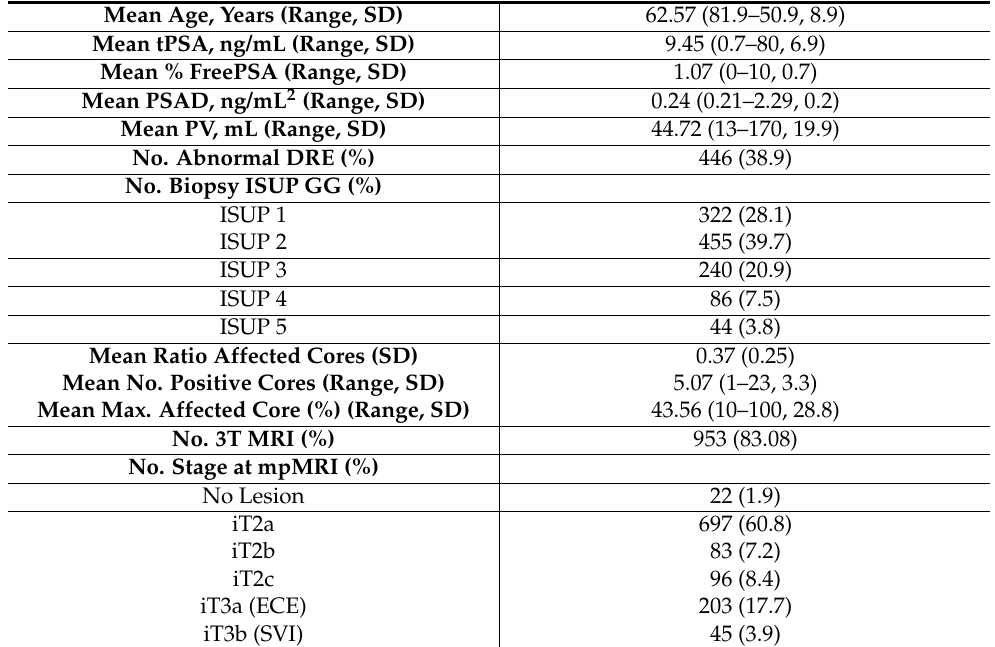
Table 1. Clinical and pathological preoperative characteristics (N = 1147).